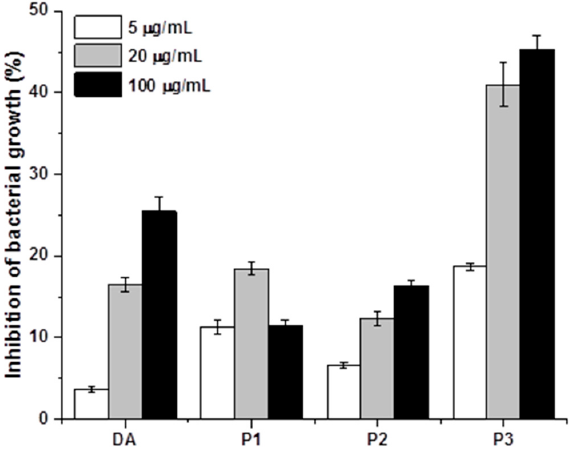
Figure 6. Comparison of the percentage of growth inhibition of S. aureus after treatment of DA and cyclotides (P1, a composite of Kalata b1, Varv A, Viba 15, and Viba 17; P2, Varv E; and P3, Viphi G) at three different concentrations ( n = 3). Error bars indicate the standard deviation of the three independent measurements.